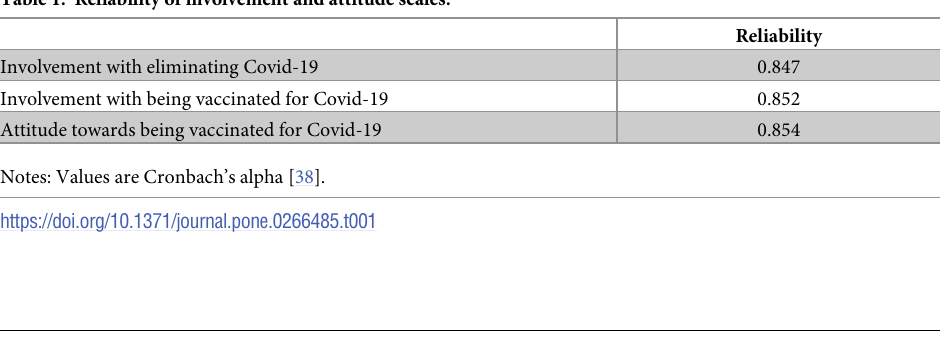
Table 1. Reliability of involvement and attitude